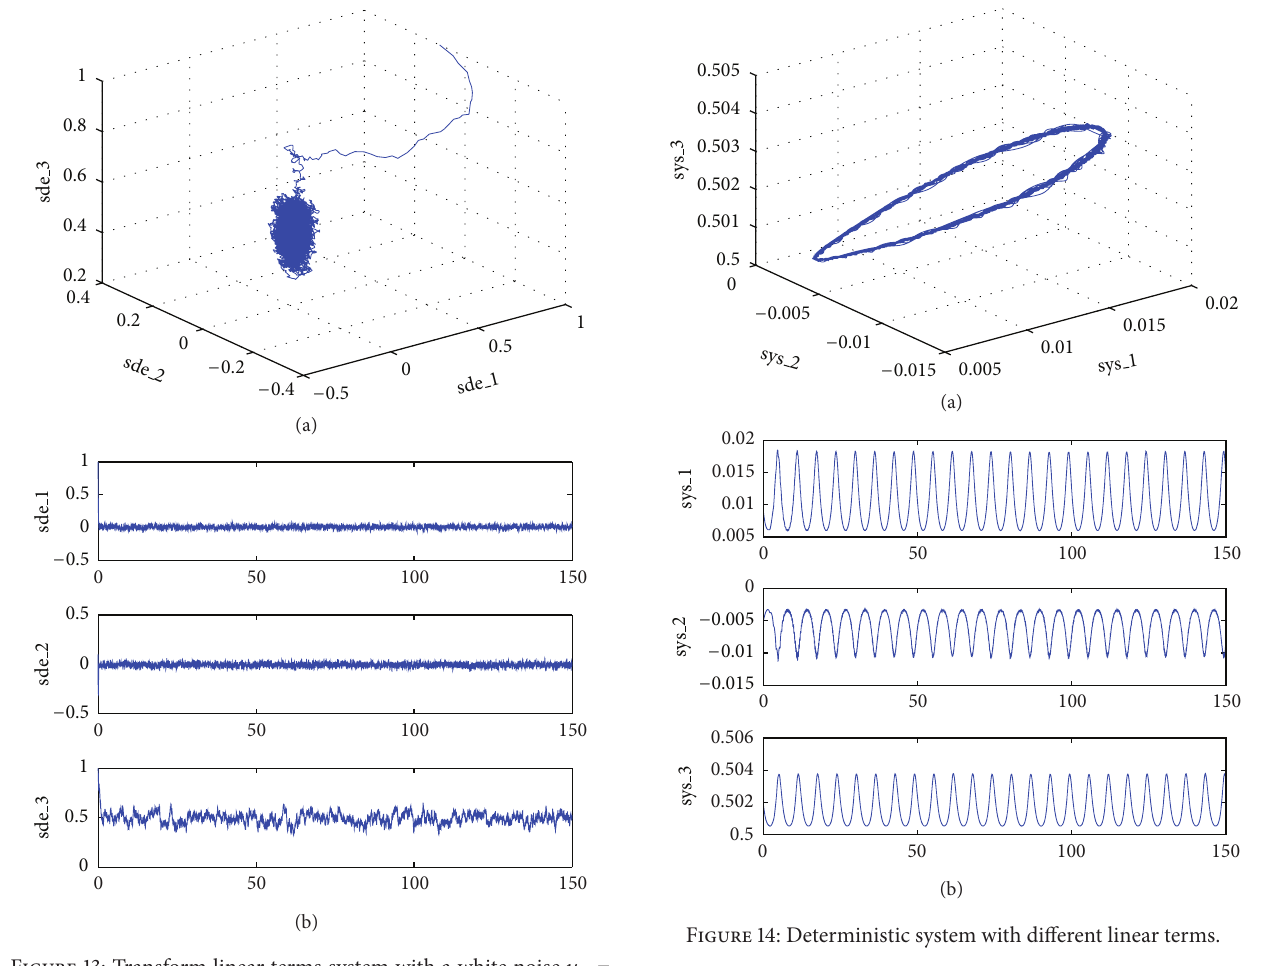
Figure 13: Transform linear terms system with a white noise 𝑢 𝑖𝑖 = 0.1 , 𝑖 = 1, 2, 3 .